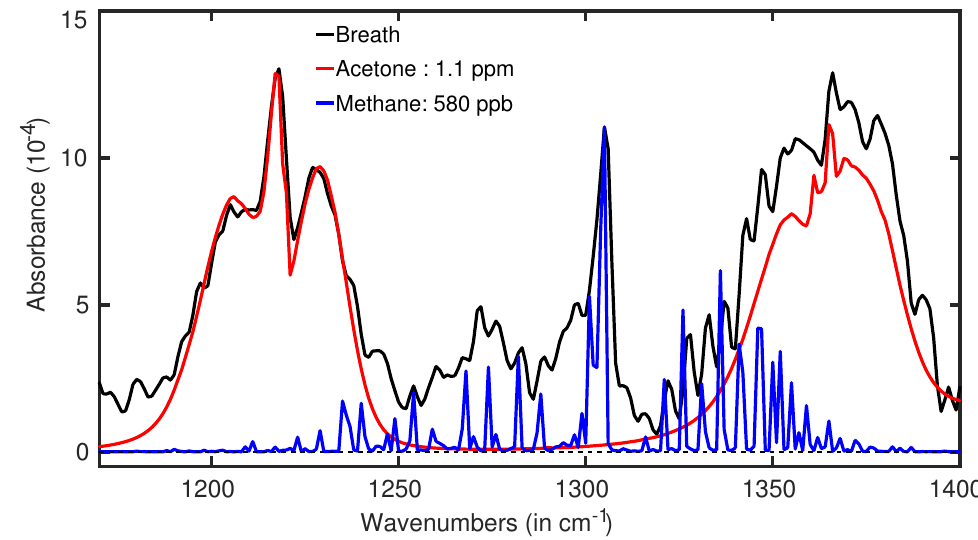
Figure 8. Acetone spectra in a real breath of a healthy volunteer (black line). The red plot is the fitting curve of acetone spectra.